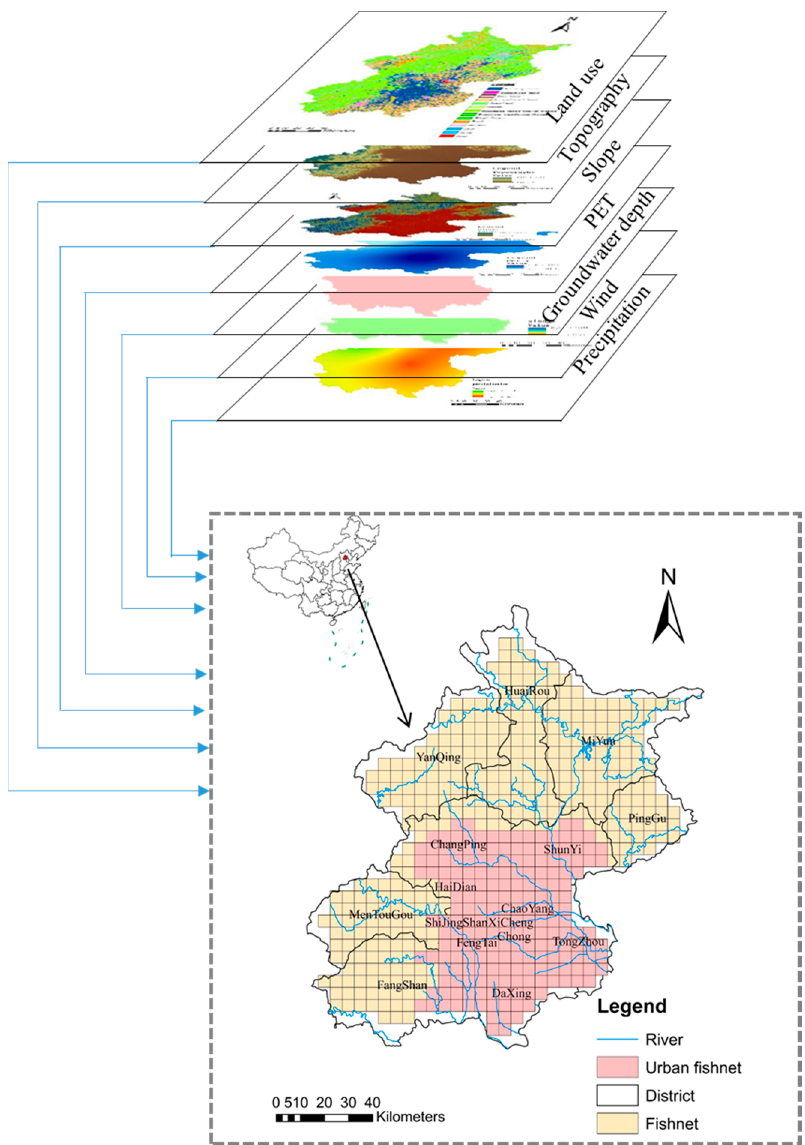
Figure 1. Location of the study area and the quadrat fishnet.